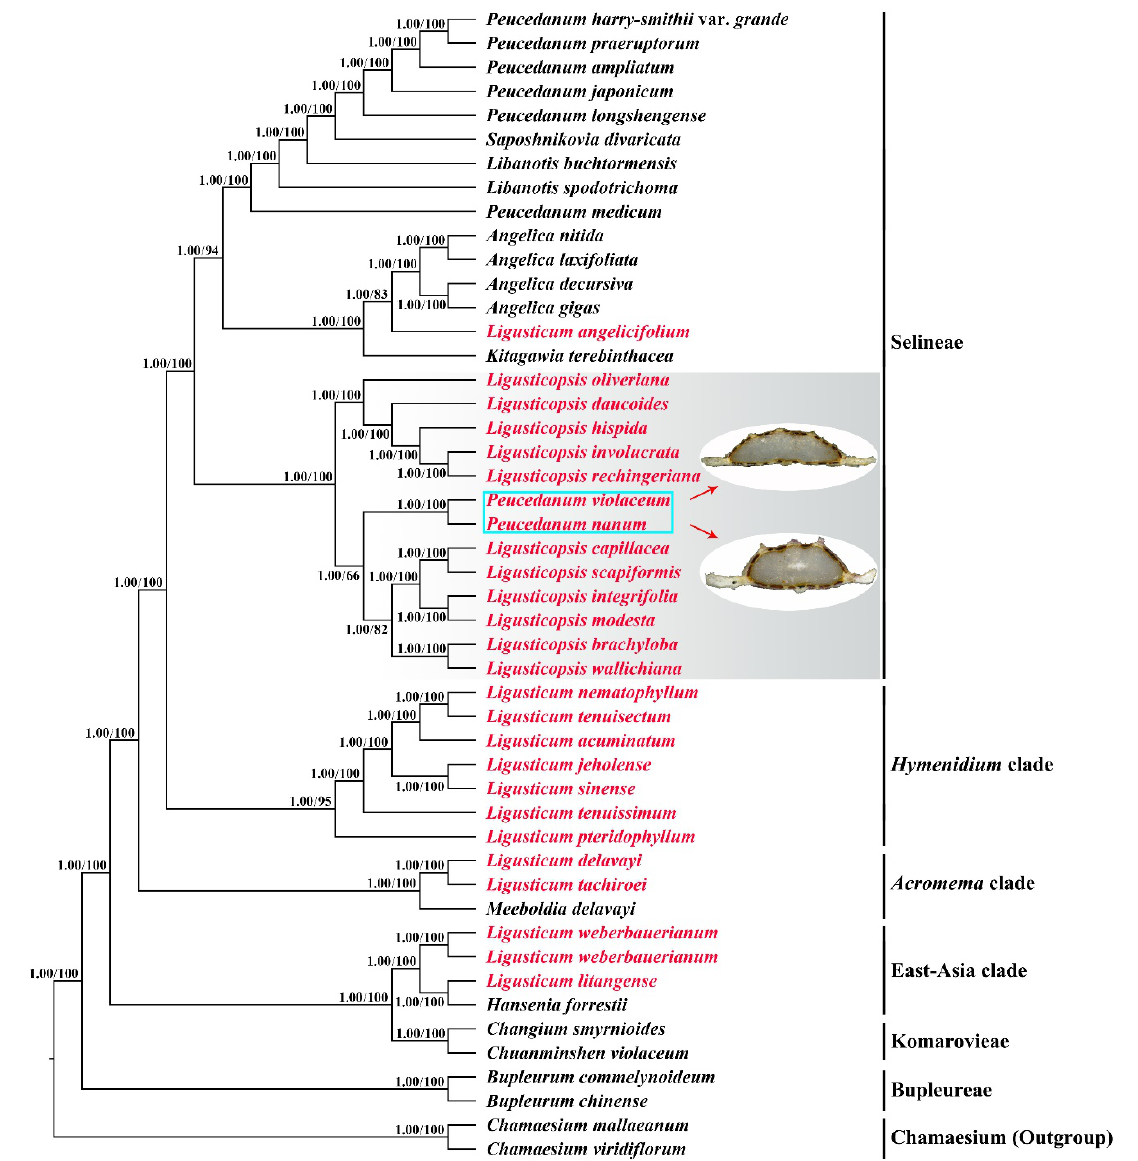
Figure 9. Phylogenetic tree inferred from maximum likelihood (ML) and Bayesian inference (BI) analyses based on plastome data. The numbers indicate Bayesian posterior probabilities (PP) and maximum likelihood bootstrap values (BS), respectively.